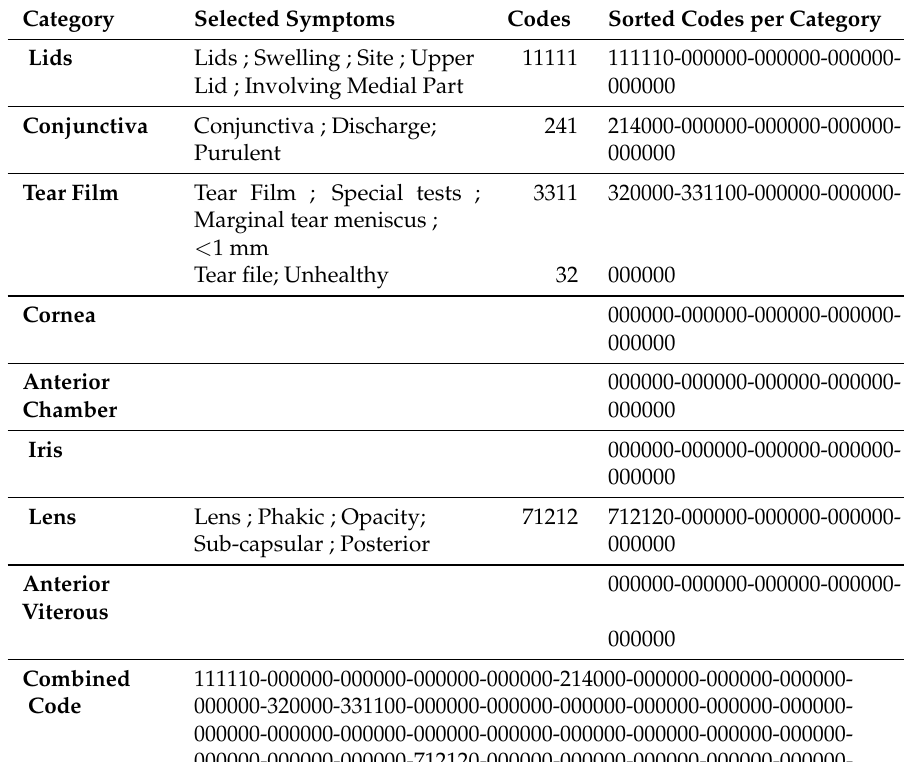
Table 2. Example of data recording in the proposed system for a patient. Combined code for symptoms facilitates fast matching and efficient diagnosis. Blank cells indicate the absence of a corresponding symptom in a particular patient and, therefore, this is represented by zeros in the code. Category Selected Symptoms Codes Sorted Codes per